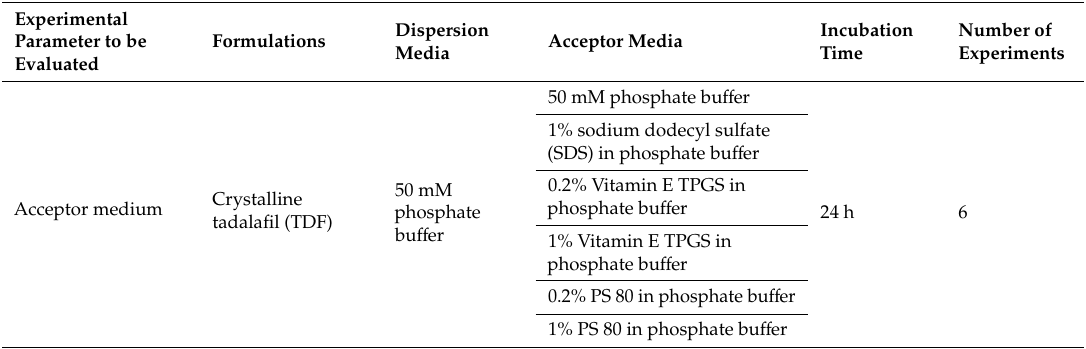
Table 2. Overview of all conducted high-throughput dissolution / permeation experiments to evaluate the influence of experimental parameters: (1) acceptor medium; (2) incubation time; and (3) dispersion